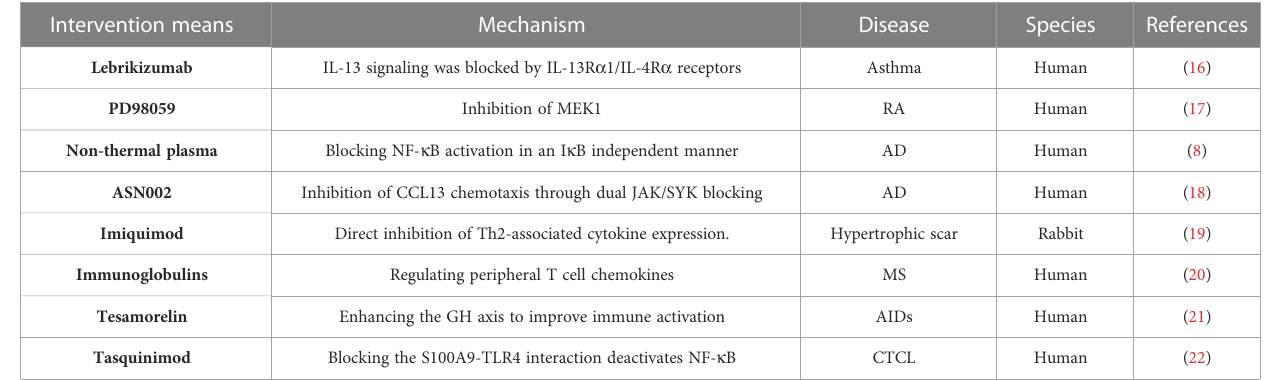
TABLE 2 Interventions to inhibit the function of CCL13 and their mechanisms. Intervention means